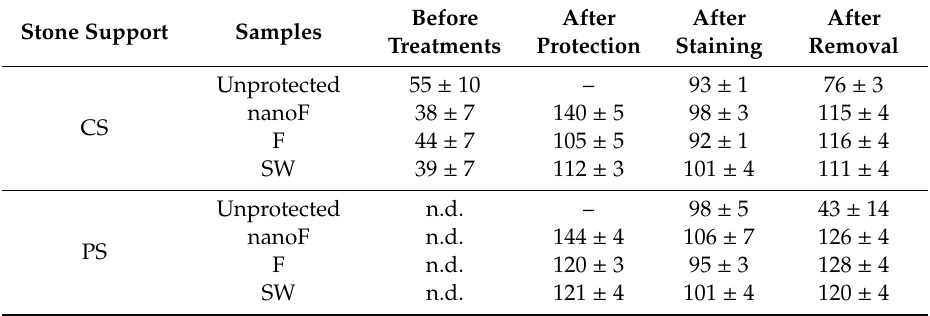
Table 4. Water-stone contact angles (in degrees) before and after the protective treatments, after the staining by spray paint, and after the cleaning. For each data set the standard deviation is reported. Stone